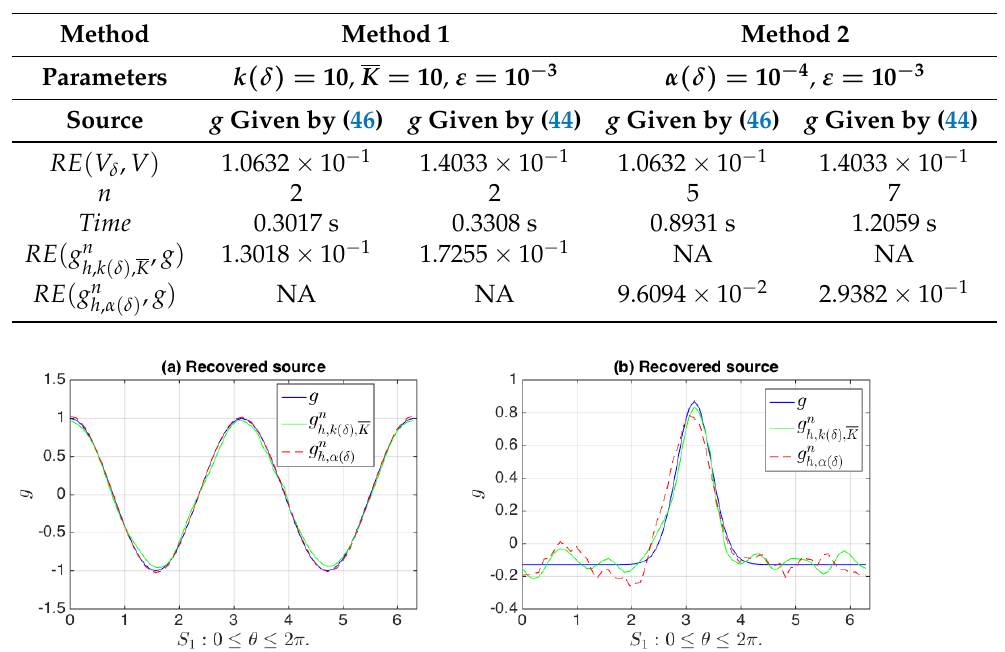
Table 6. Numerical results applying methods 1 and 2 for irregular region with noisy data V δ for δ = 0.1, using mesh M 1 ( 855,1607 ) , and with the same measurement with error V δ for each source. NA means not applicable.